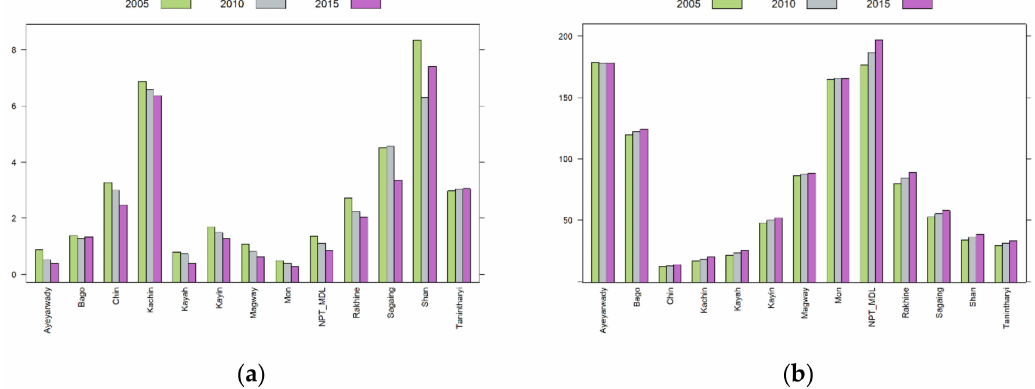
Figure 1. Bar plot: ( a ) Forest areas by state and region (unit: million ha). ( b ) Population density by state and region (unit: persons per km 2